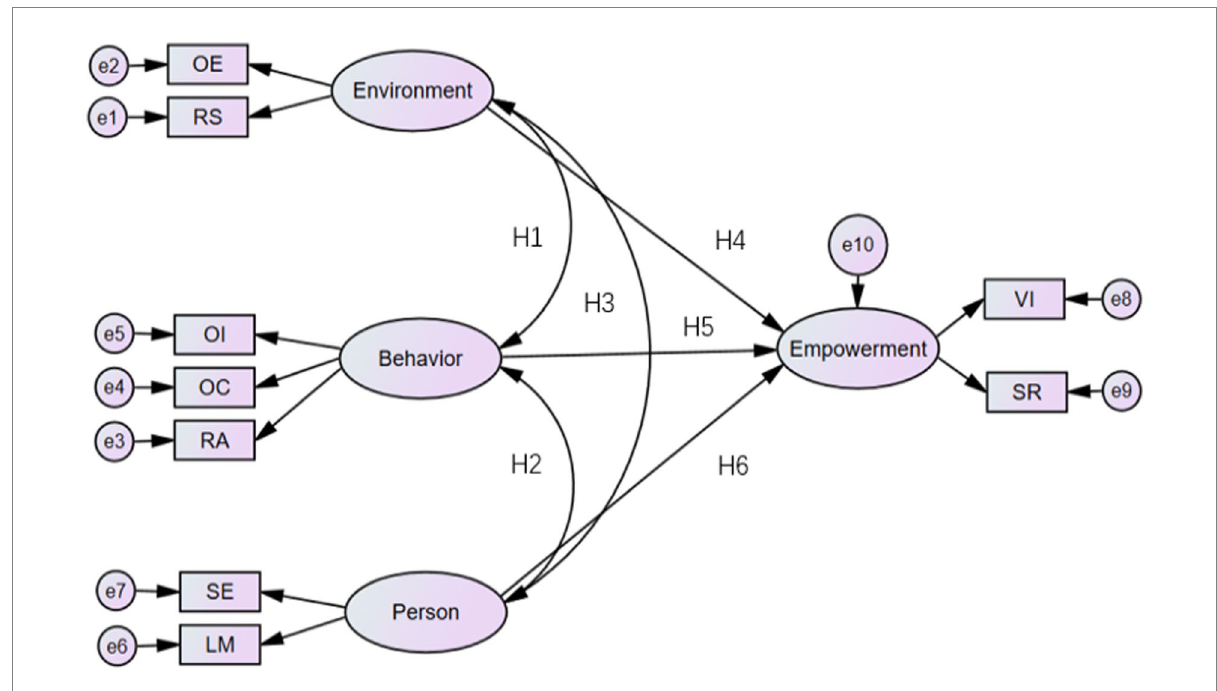
FIGURE 1 Research hypothesis